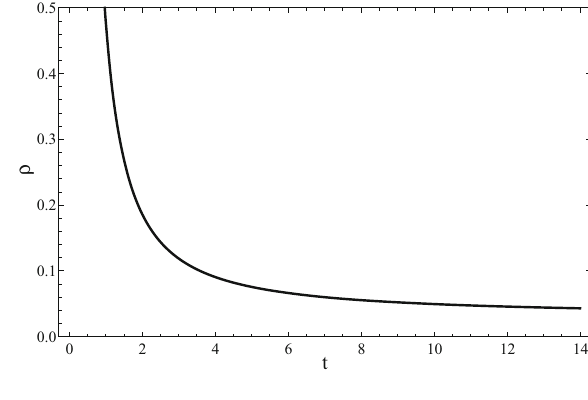
Fig. 2 DE density parameter vs. time